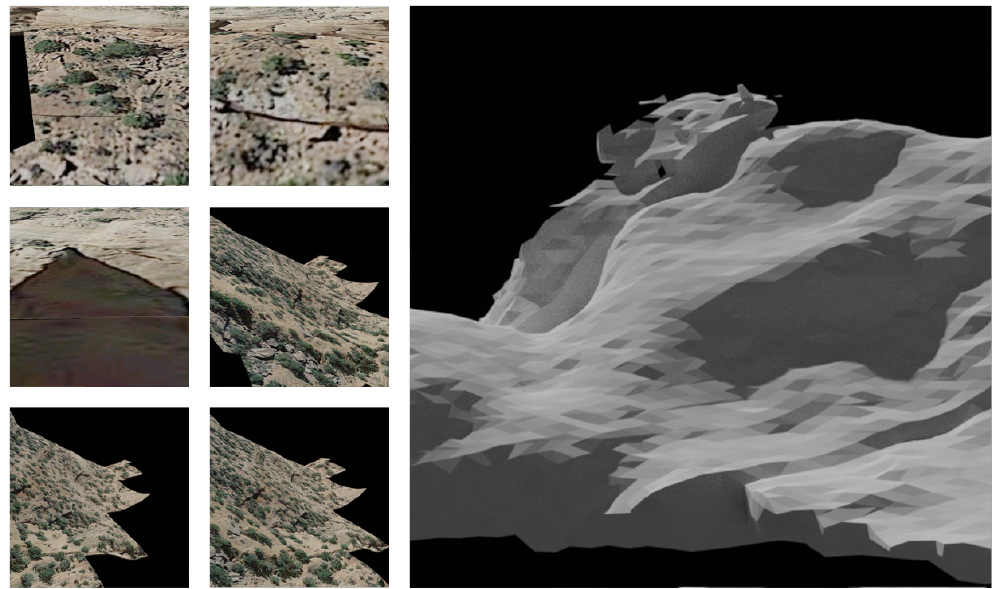
Figure 10. The real data of rocky mountain terrain. The small images on the left are the six views randomly shot by the camera, and the large image on the right is the reconstruction result.